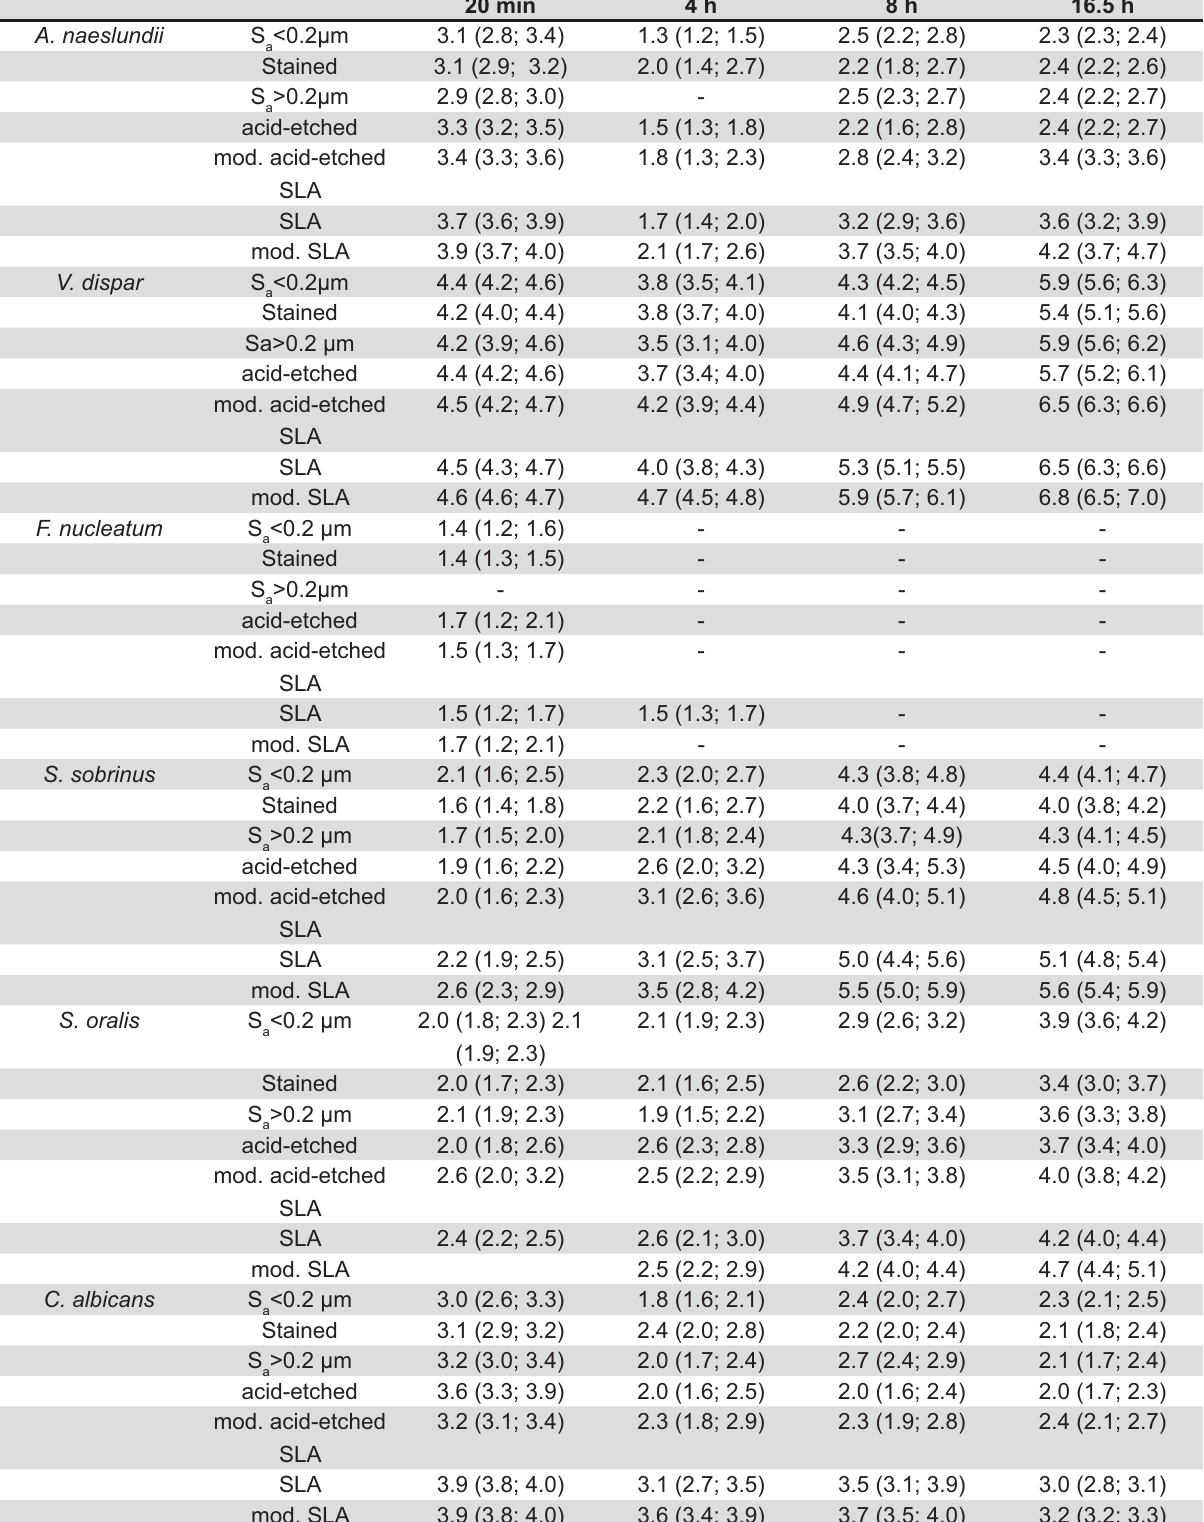
Table 3- (cid:10)&(cid:26)#(cid:26)(cid:7)(cid:23)(cid:10)’(cid:26)(cid:20)(cid:17)(cid:6)(cid:7)(cid:19)(cid:10)(cid:29)(cid:7)(cid:6)(cid:25)(cid:21)(cid:10)=#(cid:26)(cid:19)(cid:10)&\j(cid:27)(cid:10)(cid:17)(cid:8)(cid:3)(cid:7)(cid:10);(cid:3)#(cid:29)(cid:8)(cid:21)(cid:10)(cid:3)(cid:7)(cid:9)(cid:10){$(cid:30)(cid:10)(cid:4)(cid:26)(cid:7)9(cid:9)(cid:8)(cid:7)(cid:4)(cid:8)(cid:10)(cid:6)(cid:7)(cid:25)(cid:8)(cid:20);(cid:3)#(cid:21)(cid:10)(cid:6)(cid:7)(cid:10)(cid:28)(cid:3)(cid:20)(cid:8)(cid:7)(cid:25)(cid:5)(cid:8)(cid:21)(cid:8)(cid:21)Q(cid:10)(cid:26)’(cid:10)(cid:25)(cid:5)(cid:8)(cid:10)(cid:9)(cid:6)’’(cid:8)(cid:20)(cid:8)(cid:7)(cid:25)(cid:10)(cid:21)(cid:28)(cid:8)(cid:4)(cid:6)(cid:8)(cid:21)(cid:10) determined on the various surfaces at the given time points (N=9 per group; ANOVA and Scheffé post hoc